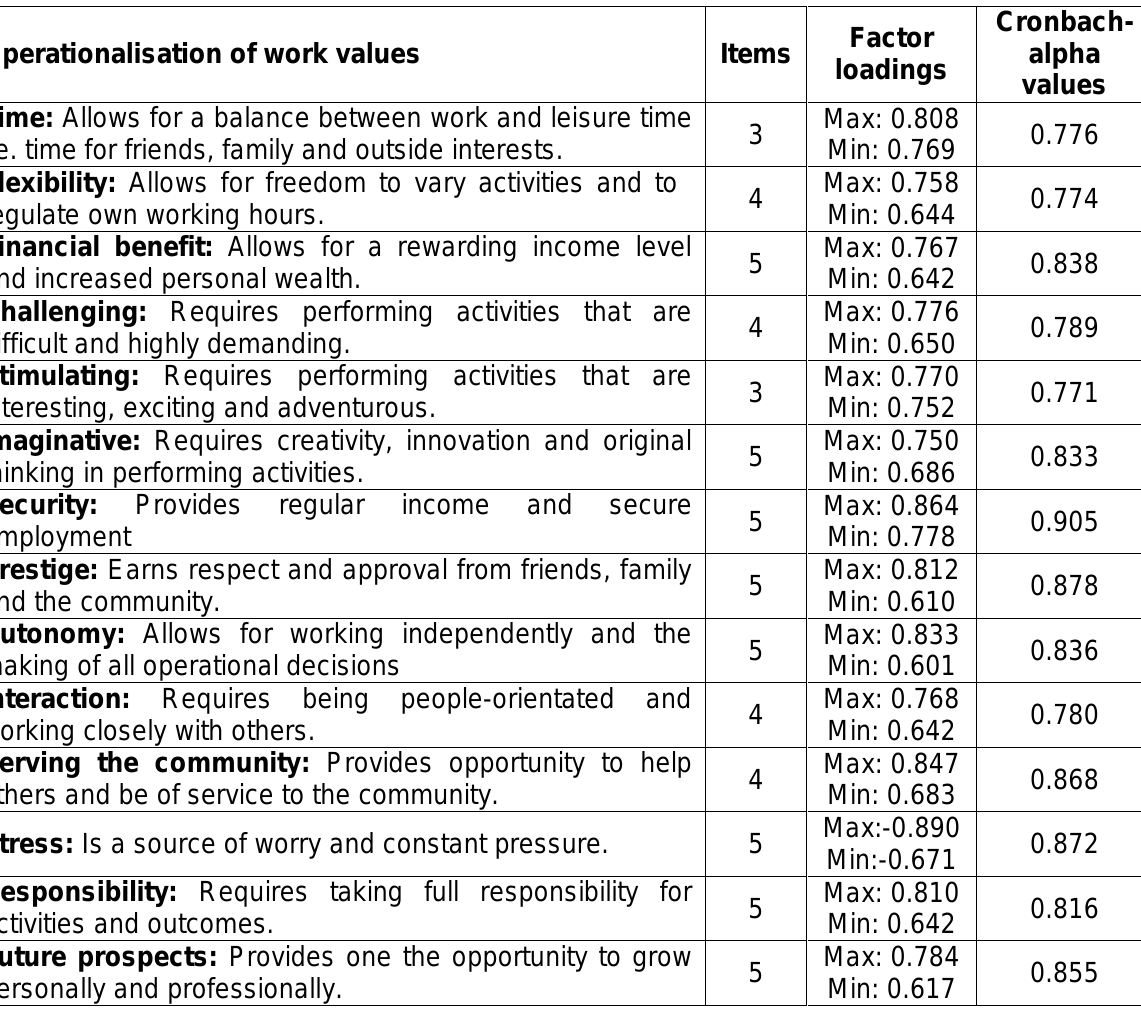
TABLE 2 MEASUREMENT INSTRUMENT ANALYSIS Operationalisation of work